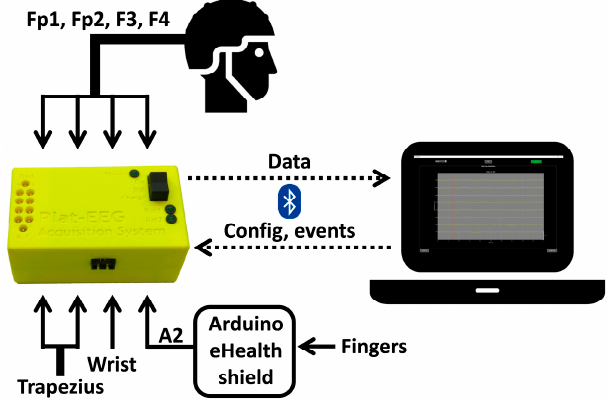
Figure 2. Diagram of the full portable system for real-time detection of stress level. The system is composed by the RABio w8, multiple biosignal sensors placed at head, trapezius, wrist and fingers, the Arduino e-Health platform, and a laptop.